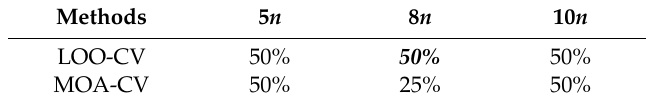
Table 8. Accurate rate of selecting best models by mean of LOO-CVerror and MOA-CVerror.